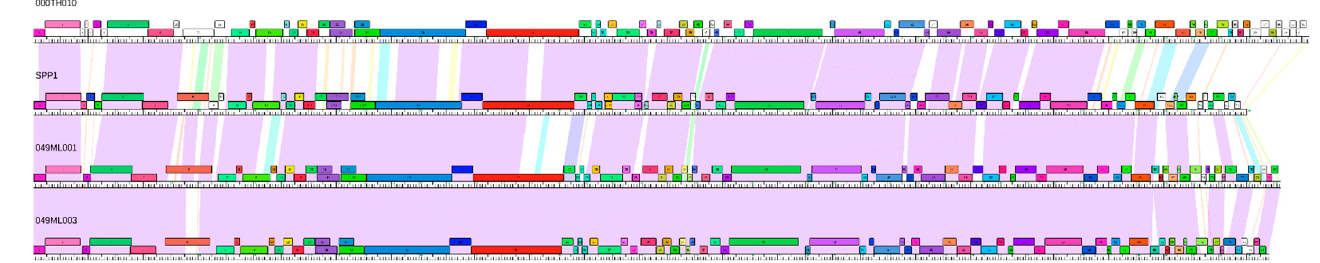
Figure 4. Genome maps of the phages of cluster SPP1. Gene boxes are colored based on pham membership, as determined by amino acid (aa) alignment using BLASTp and Clustalw done within Phamerator [52], using a database of 250 Bacillus phages. Genes that are found in only one phage or show limited aa similarity (less than 32.5%) are in white. The color spectrum between two adjacent sequences reflects nucleotide sequence similarity as measured by pairwise local alignment using BLASTn “align two sequences”, with lavender being the most similar (E = 0) and red being the least similar (E = 10 − 4 , set as the minimal threshold). A lack of shading indicates that the minimal similarity threshold has not been met (E score greater than 10 − 4 ). A total of 116 phams among these four phages were identified.